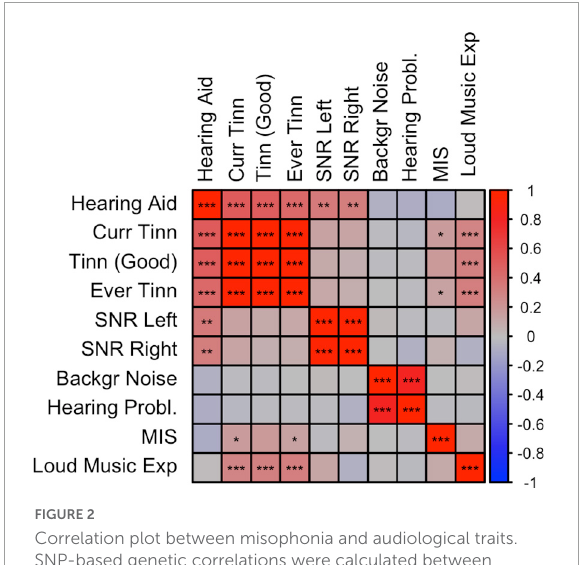
FIGURE3 Correlation plot between misophonia, psychiatric, and psychological traits. SNP-based genetic correlations were calculated between misophonia, tinnitus (current), and 12 selected traits shows the membership of two main clusters identified using hierarchical clustering, putatively called the irritability and neuroticism clusters. The neuroticism cluster holds most internalizing traits. The irritability cluster also holds sensitivity, tenseness, and worry. The psychiatric traits are clustered with the neuroticism cluster but all showed significant positive correlations with the irritability cluster. Misophonia closely followed the psychiatric traits. Tinnitus showed a pattern different from misophonia with high correlations with the neuroticism cluster but no significant correlations with the irritability cluster. * p < 0.05, ** p < 0.01, *** p < 0.001, false discovery rate (FDR) adjusted across all traits combinations. See Supplementary Table 1 for